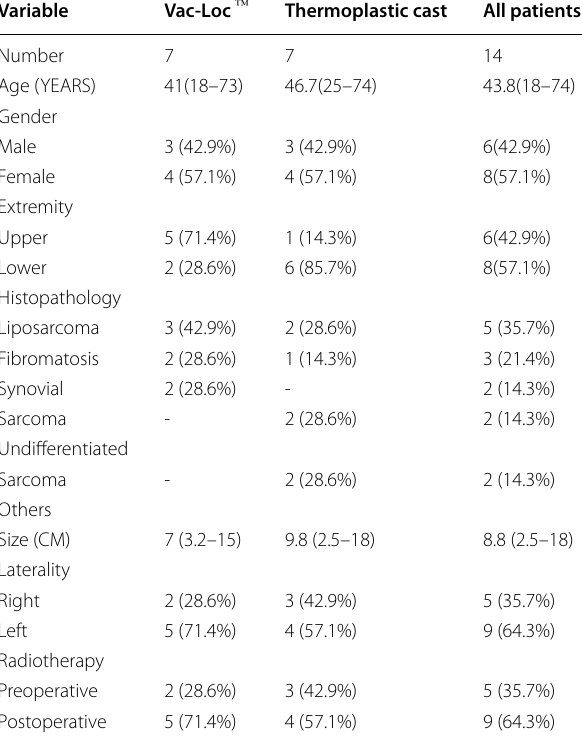
Table 1 Patient